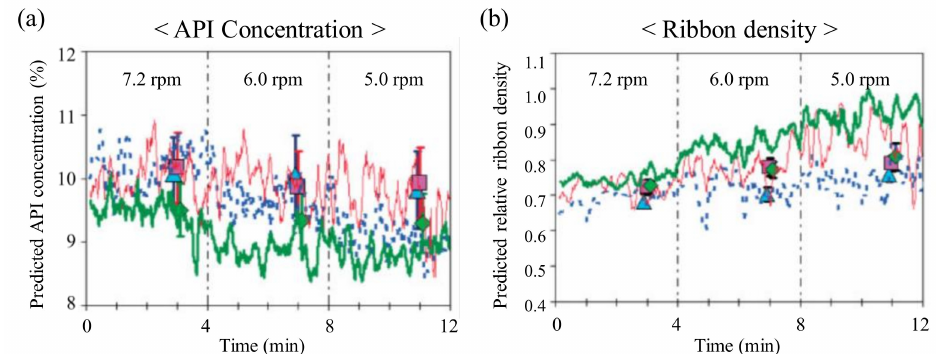
Figure 14. Predicted values estimated from NIR data at a relative humidity of 24% (blue), 45% (red) and 65% (green). Active pharmaceutical ingredient (API) concentrations determined using UV analysis are represented as triangles (24% RH), squares (45% RH) or diamonds (65% RH). The roll speed was changed every 4 min [157]: ( a ) API concentration (%); ( b ) relative ribbon density. The figures were slightly modified, with permission from Elsevier.